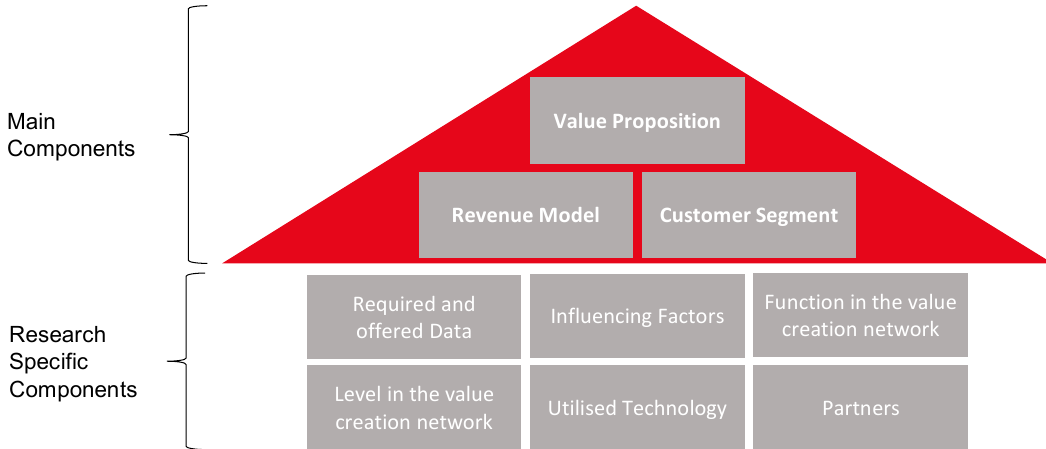
Figure 6. Overview of the components of the business model framework for the energy transformation (BMFE). According to this logic, the main components within a business model prototype are